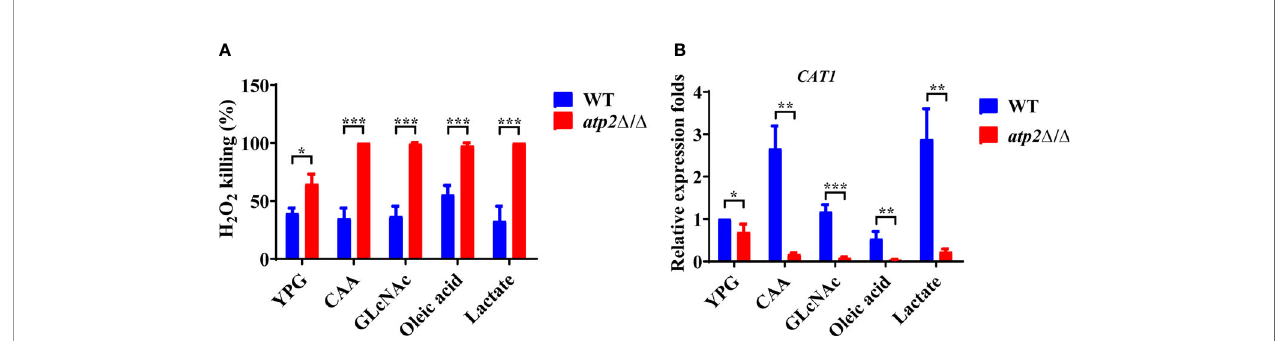
FIGURE 8 | C albicans cells lacking ATP2 are more vulnerable to oxidative stress in macrophage-mimicking media. (A) The percentage of C albicans cells killed by 6 mM H 2 O 2 in YNB medium plus 2% glucose, CAA, GLcNAc, oleic acid, and lactate at 6 h. The killing rate was determined by comparison with C albicans recovered without H 2 O 2 . (B) Relative expression levels of CAT1 in different media, and the expression level of WT in YNB + 2% glucose was set as 1. In (A, B) , data are shown as mean ± s.d. * P< 0.05, ** P <0.01, *** P <0.001; by Student ’ s